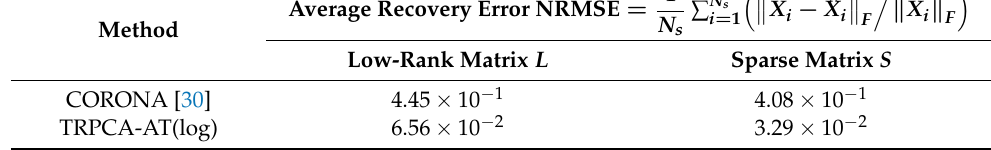
Table 3. Comparison with CORONA [30] for generic Gaussian data. Our proposed approach TRPCA-AT(log) outperforms the CORONA. This is due to the fact that the CORONA is optimized for structured sparsity of ultrasound data, which is not present in generic Gaussian